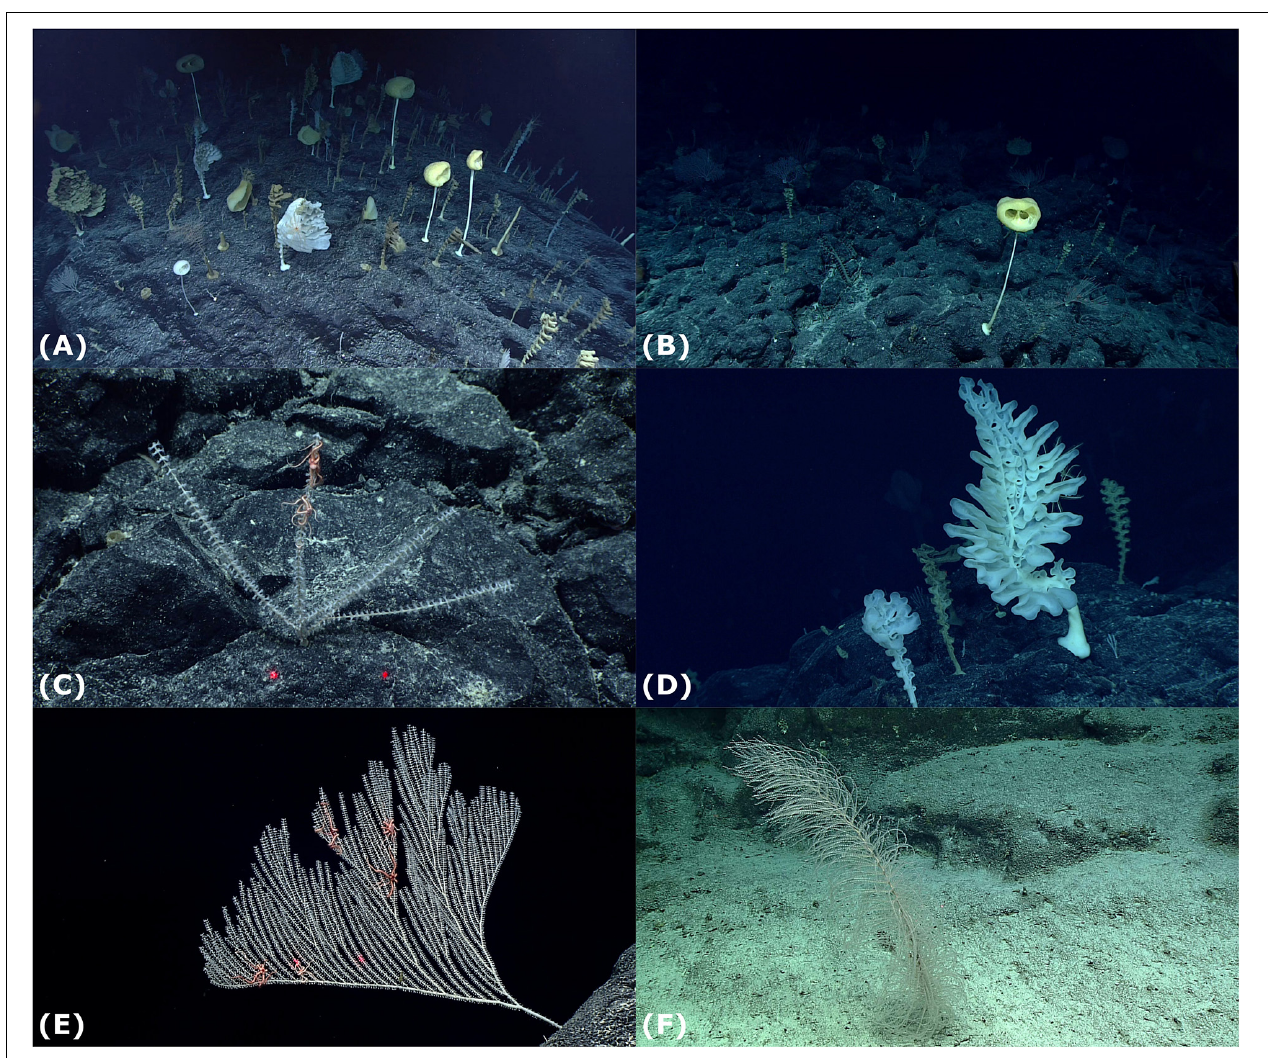
FIGURE 1 | Different taxa identified within this study. Red laser dots are 10 cm apart. (A) A photograph of the Ridge Crest Area, (B) Advhena magnifica , (C) Narella macrocalyx, (D) Aspidoscopulia, (E) Narella bowersi , and (F) Rhodaniridogorgia